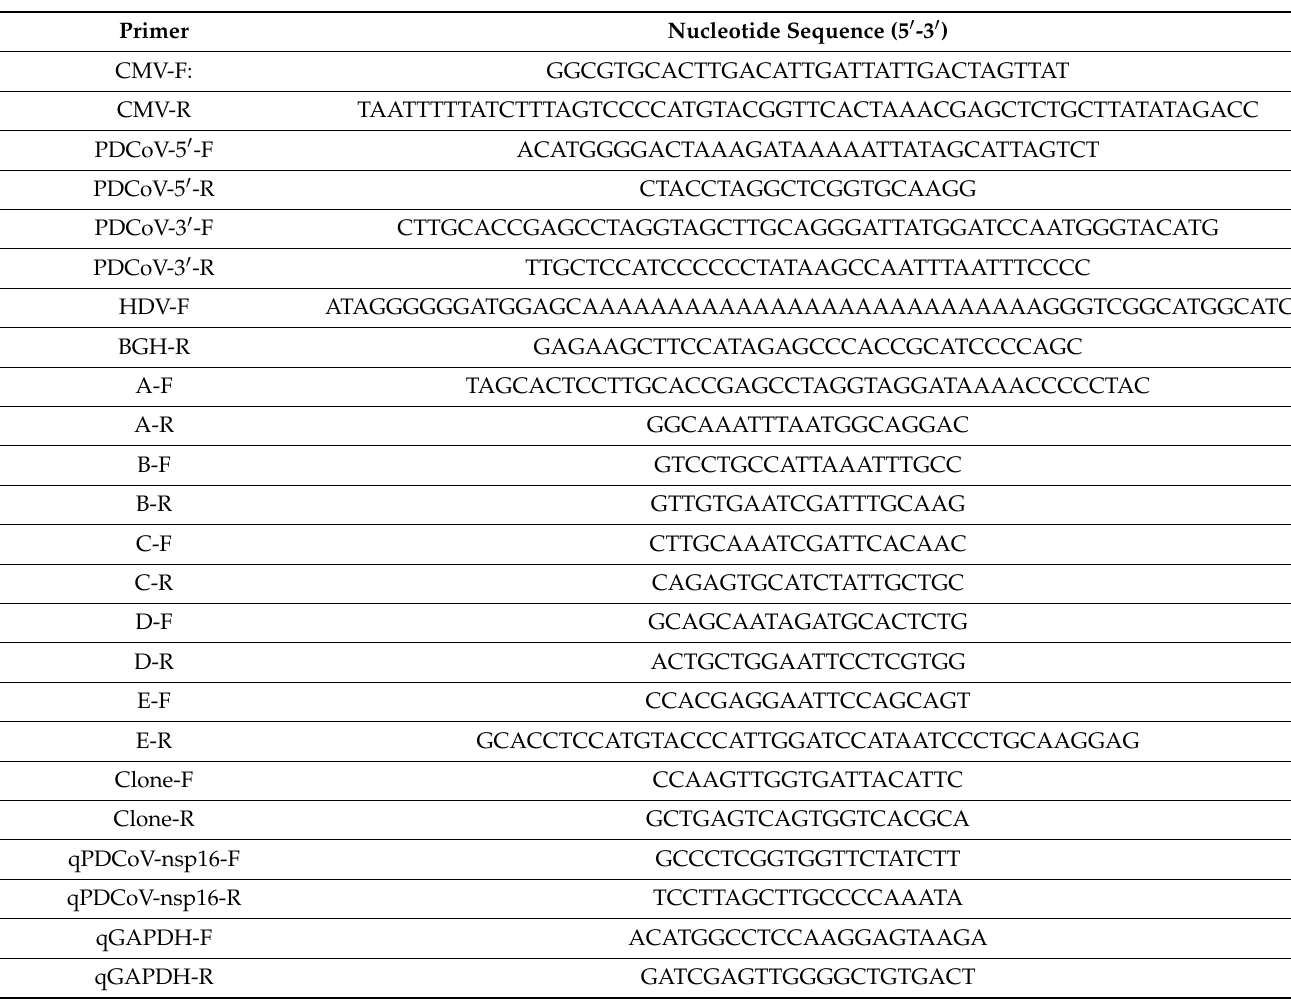
Table 1. Primers used for the RT-PCR amplification of PDCoV full-length genome, the construction of plasmids and real-time RT-PCR